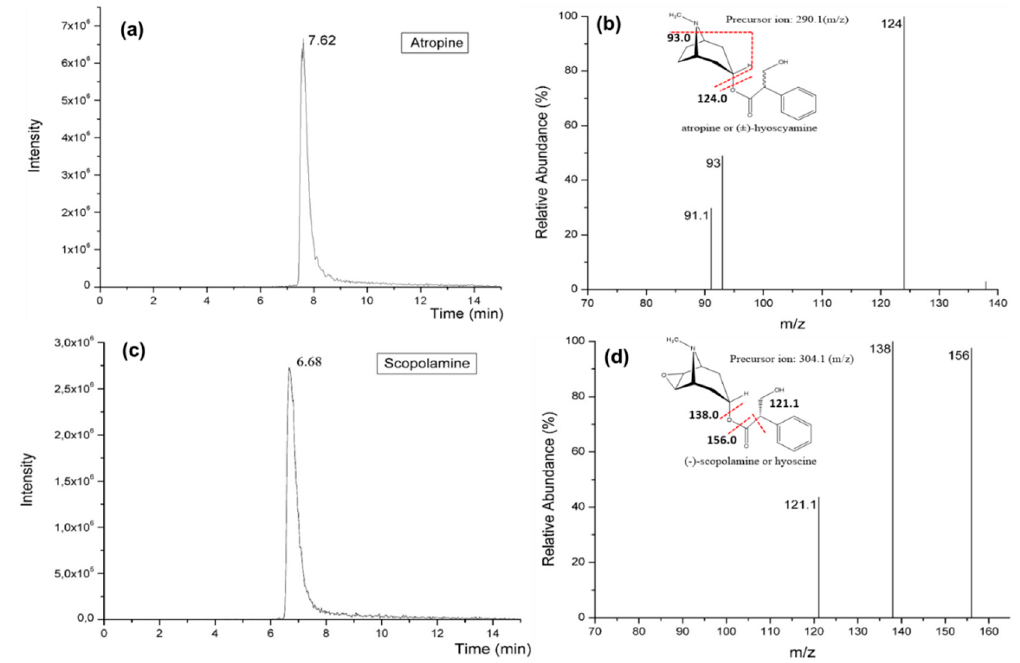
Figure 5. Standard solution mixture of atropine and scopolamine (0.2 µg/mL). ( a ) Extracted ion chromatogram for atropine (m/z 290.1 > 124.0), ( b ) fragment ions mass spectrum of atropine, ( c ) extracted ion chromatogram for scopolamine (m/z 304.1 > 138.0), ( d ) fragment ion mass spectrum of scopolamine.